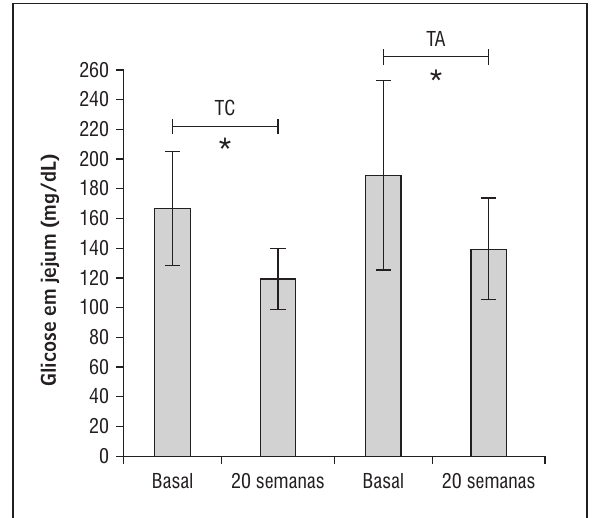
Gráfico 1 - Valores (média e desvio-padrão) da glicose (mg/ dL) basal e após 20 semanas de programa